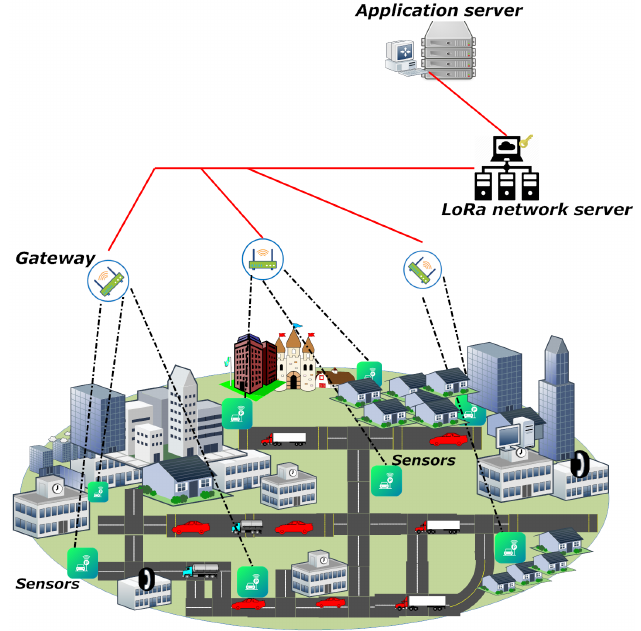
Figure 1. An exemplary illustration of the LoRaWAN-enabled network